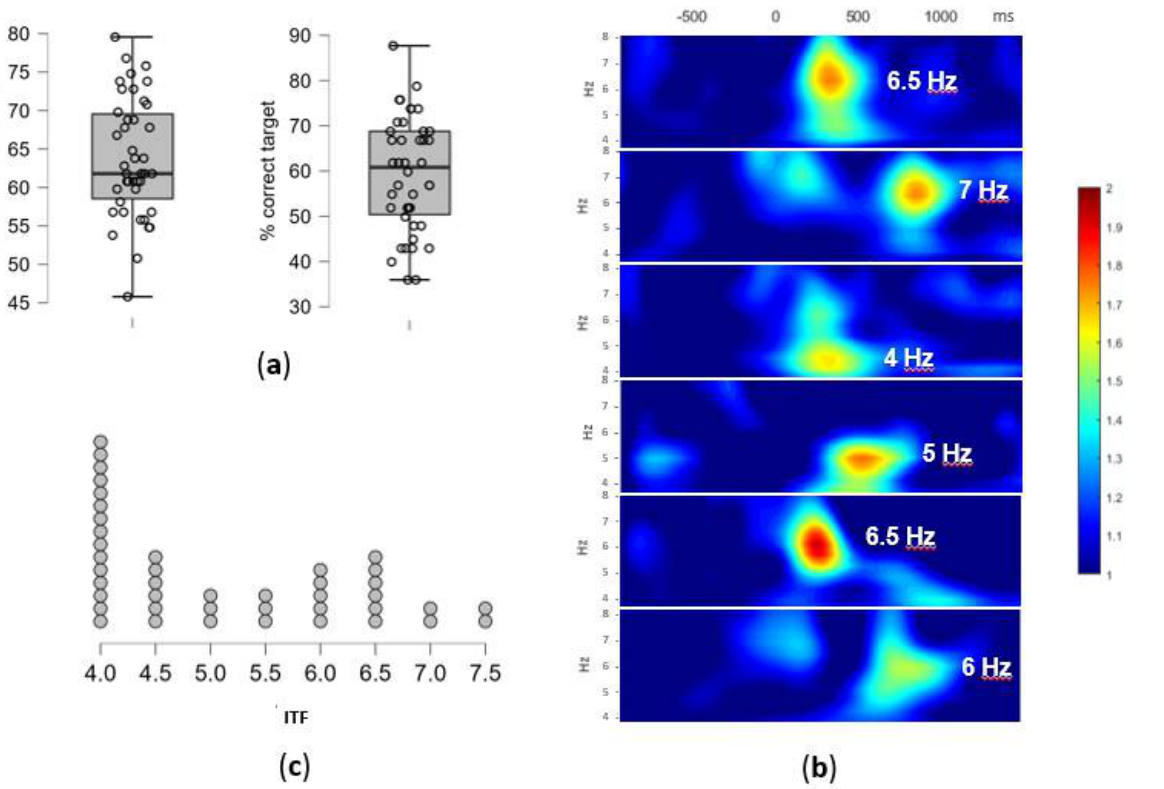
Figure 3. ( a ) The AM task performance: the overall success rate in % and the % of correctly identified targets, i.e., successfully encoded pairs. Individual participants overlay the box-plot marking median and interquartile range ( b ) The individual differences in theta activity during the AM encoding: examples of time-frequency plots of the EEG signal during the successfully encoded pairs for six participants; the ERSP values, averaged across 9 centro-parietal electrodes, are plotted within the window of − 800 and 1250 ms (x-axis) and 4–8 Hz (y-axis), with the extracted ITF for each participant marked; ( c ) The individual theta frequency (ITF) distribution: the number of participants and their extracted ITF values in Hz (x-axis).